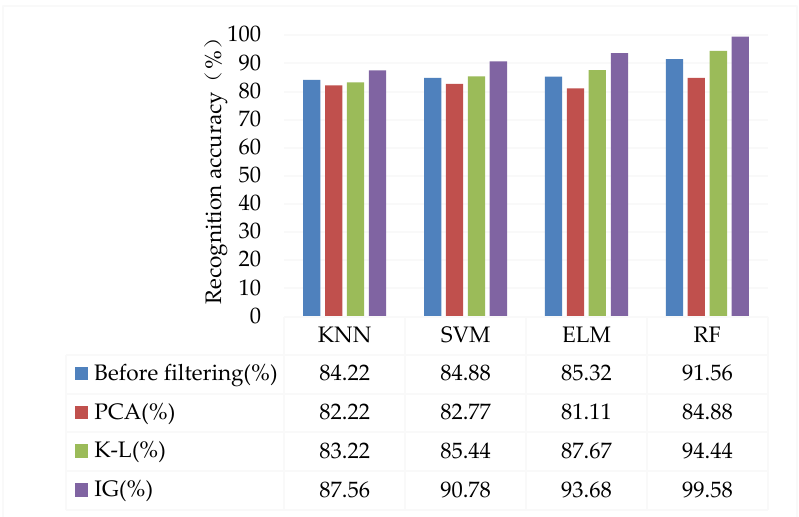
Figure 9. Identification accuracy of different IMF components screening methods.